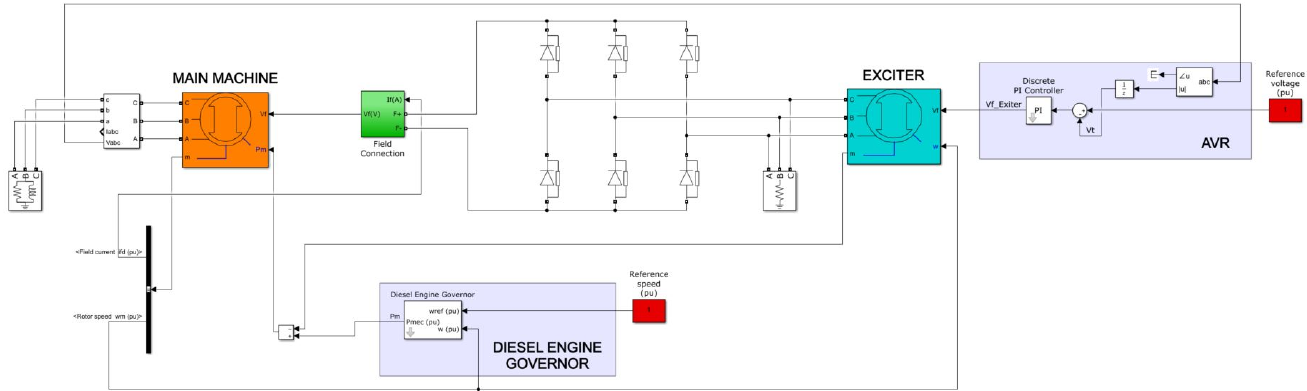
Figure 4. Computer simulation model.